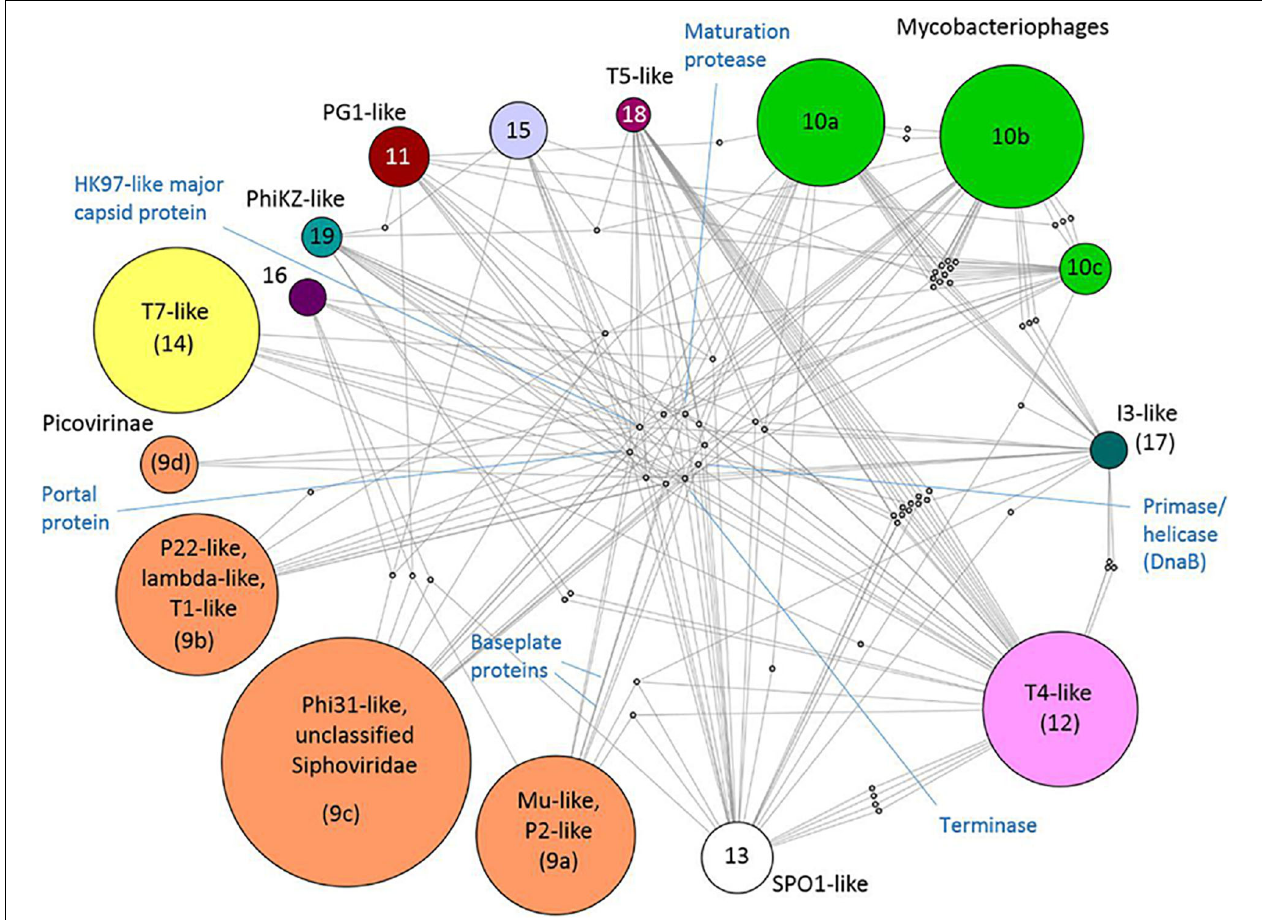
FIGURE 5 | Taken from Iranzo et al. (2016). Internal structure of the Caudovirales supermodule. A bipartite graph is displayed, linking bacterial modules to the genes they share. Proteins that represent hub nodes in the gene-sharing network are labeled. License: CC Attribution 4.0 International